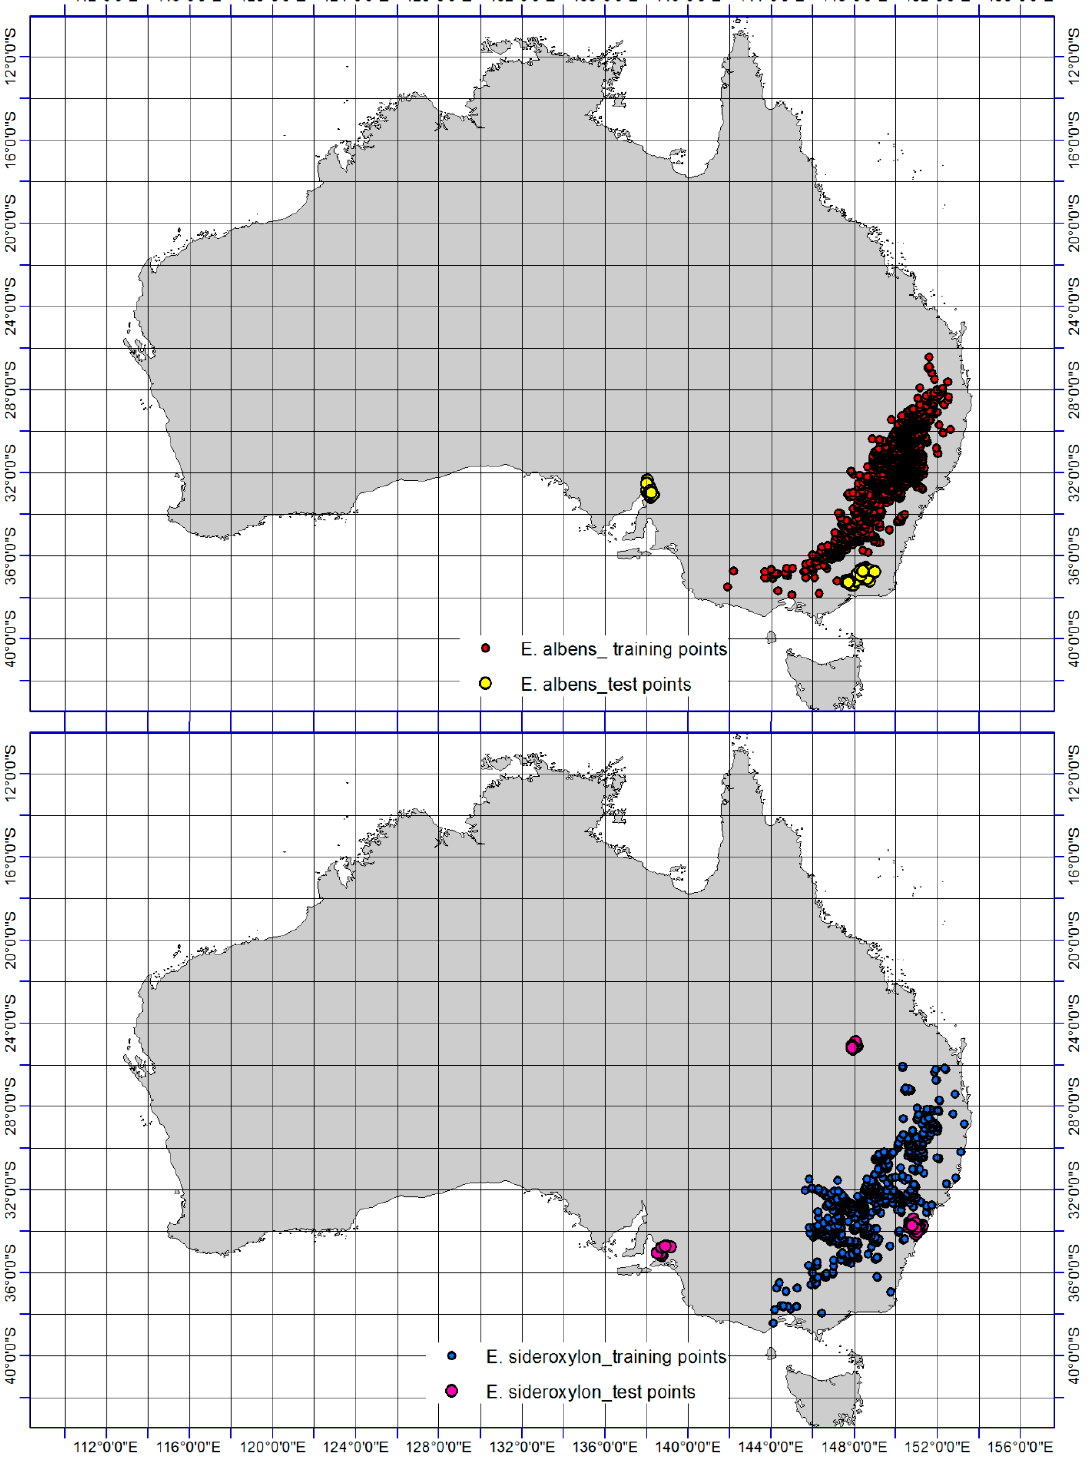
Figure 1. Distribution records (test and training points) of Eucalyptus sideroxylon and E. albens . Training points were used to develop climate suitability models while test points were kept aside for model validation purposes.